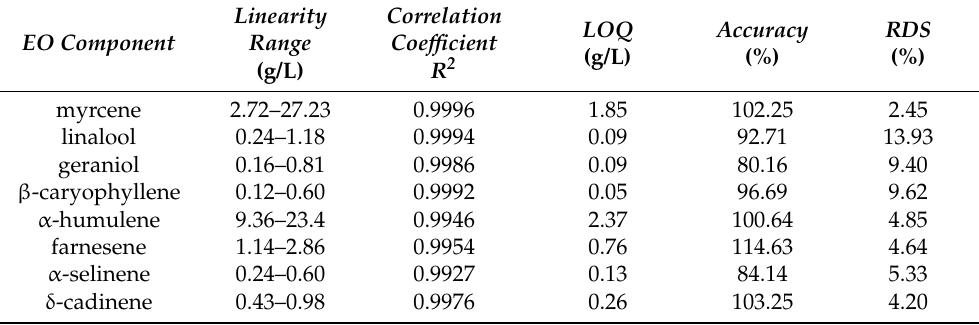
Table 1. Concentration range, correlation coefficients, accuracy, repeatability and LOQ